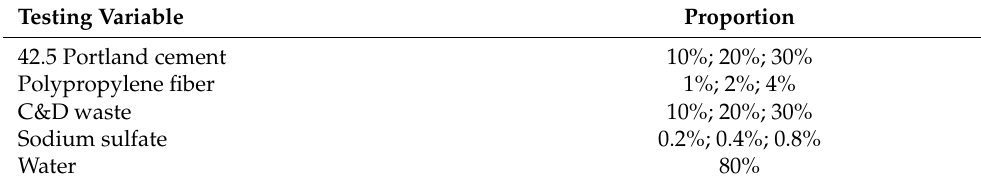
Table 4. Testing variables and